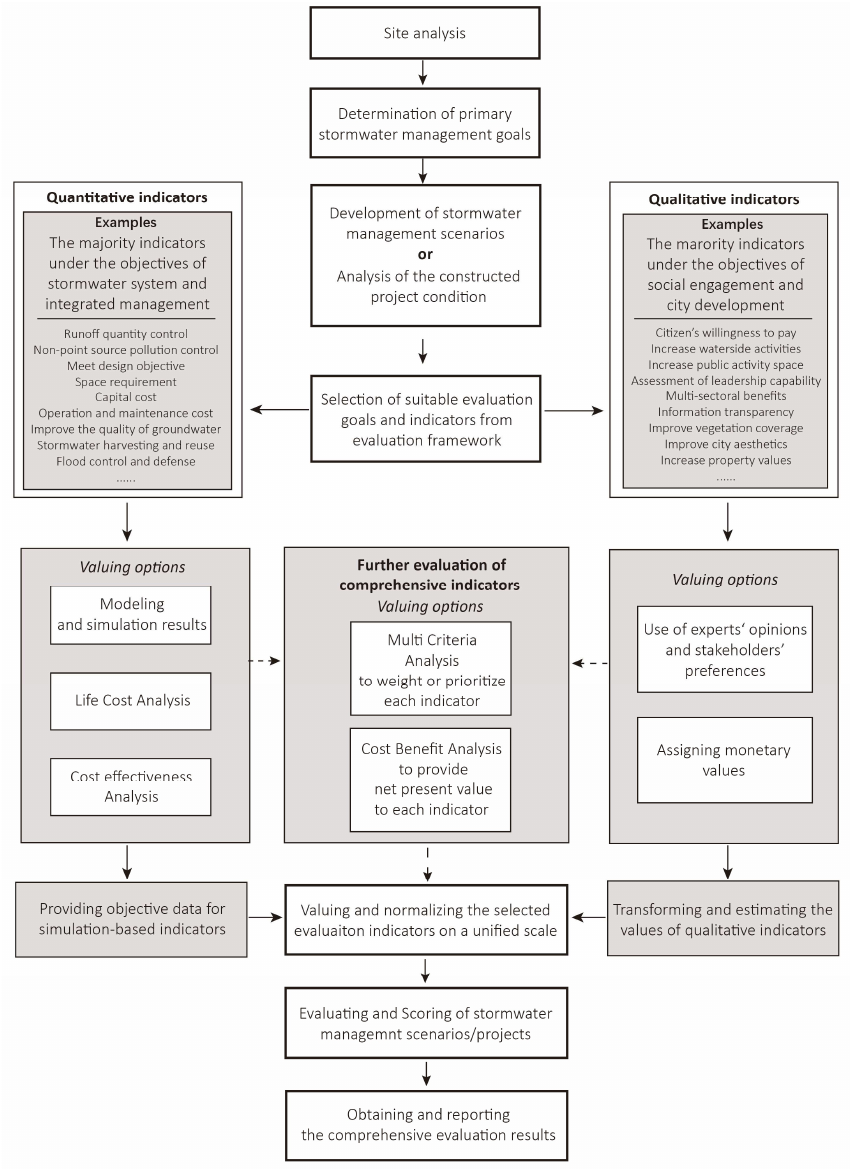
Figure 4. Procedure and methods for comprehensive evaluation of SSWM.